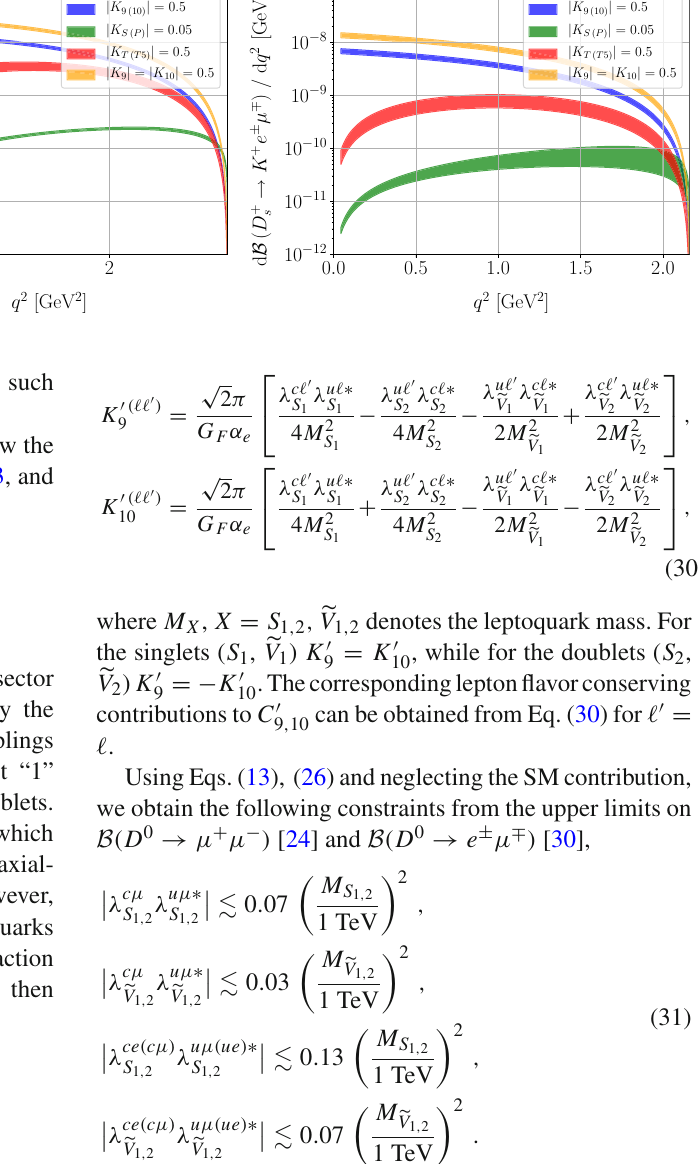
Fig. 7 The differential branching ratio of D + → π + e ± μ ∓ (plot to the left) and D + s → K + e ± μ ∓ (plot to the right) decays in different LFV-BSM